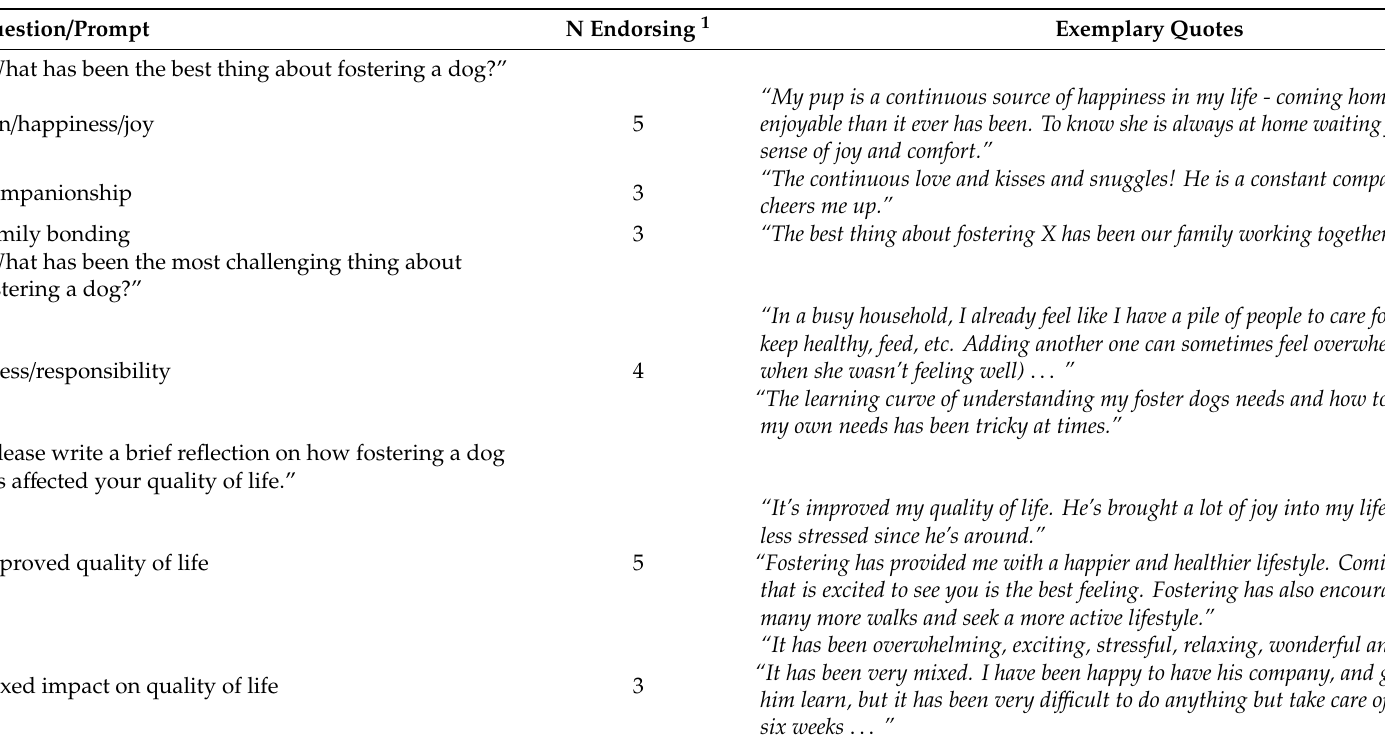
Table 2. Open-ended participant responses at 6 weeks in the